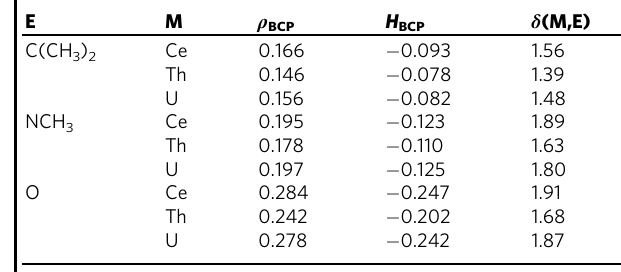
Table 2 QTAIM properties (PBE0) for the M – E interaction